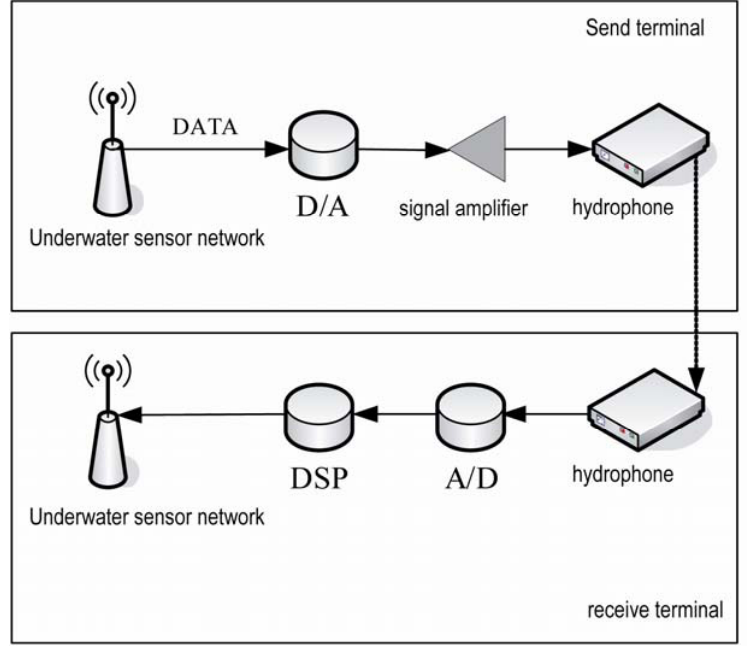
Figure 12. Communication process of an underwater sensor